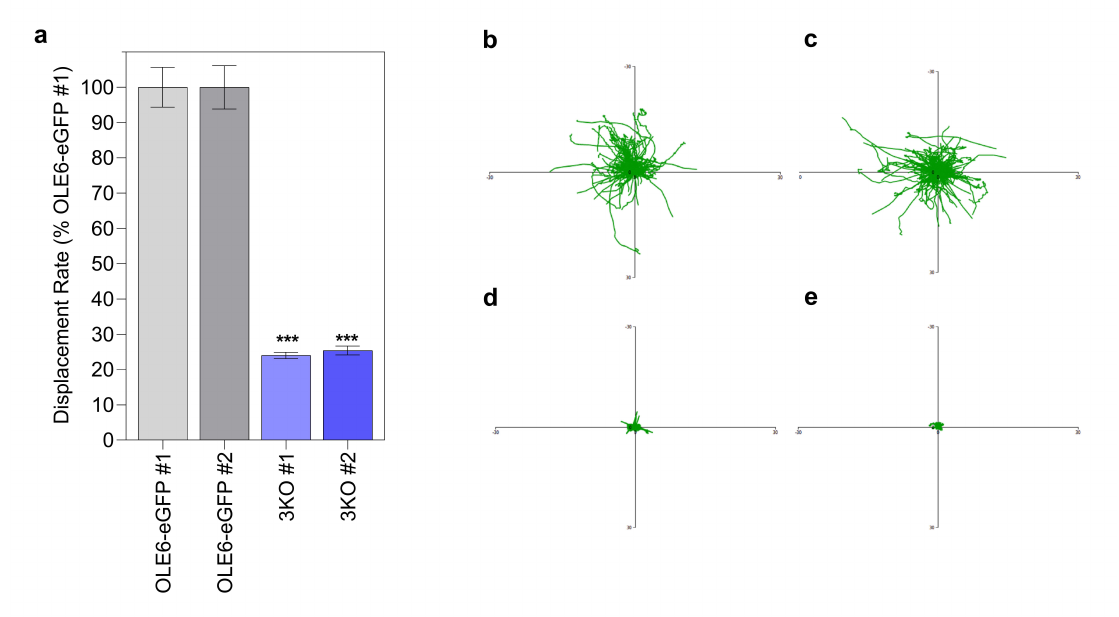
Figure 5. Movement of lipid bodies in PtOLE6-eGFP -overexpressing myosin 3KO plants. ( a ) Mean displacement rates of the lipid bodies in two independent PtOLE6-eGFP expressing lines in the myosin3ko background expressed as percentages ( ± SE) of those in the OLE6-eGFP #1 (0.45 µ m / s). ( b – e ) Representative tracks of lipid bodies present in OLE6-eGFP #1 ( b ), OLE6-eGFP #2 ( c ), 3KO #1 ( d ), and 3KO #2 ( e ) in a time series obtained with the CLSM and plotted to a common origin. Asterisks indicate significant di ff erences between control and the mutants (*** p <